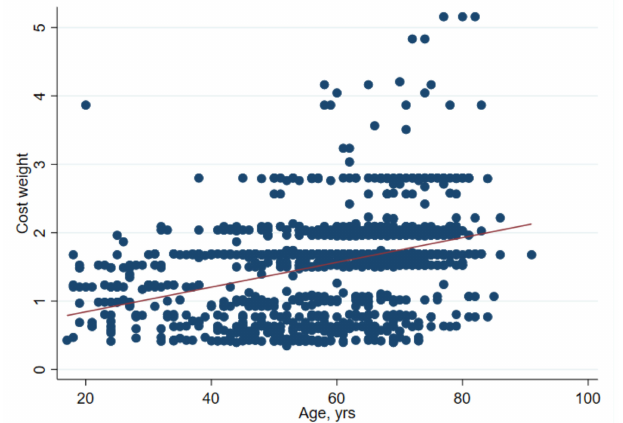
Figure 5. Correlation between age and cost weight. Cost weight increases proportionally with age, indicating the increased burden of treatment and comorbidities associated with older